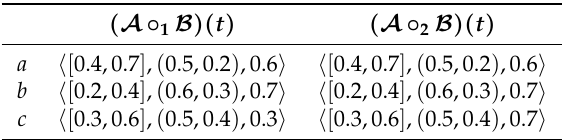
Table 2. ( A ◦ 1 B )( t ) and ( A ◦ 2 B )( t ) .